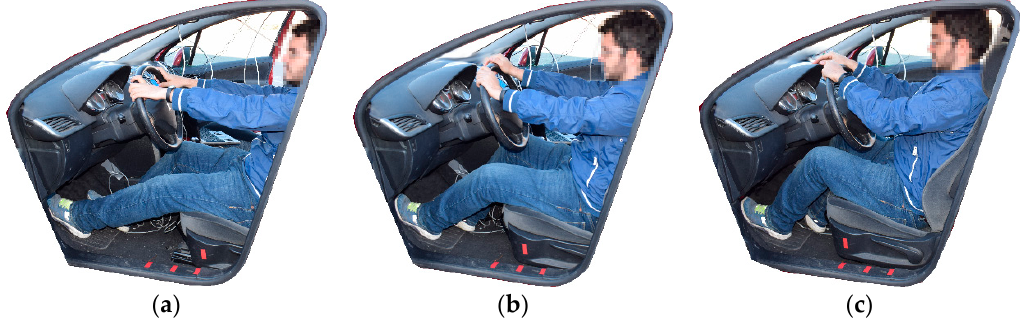
Figure 3. Position of the driver depending on the HC distance. ( a ) HC = 1 m, ( b ) HC = optimal distance, ( c ) HC = 0.75 m.